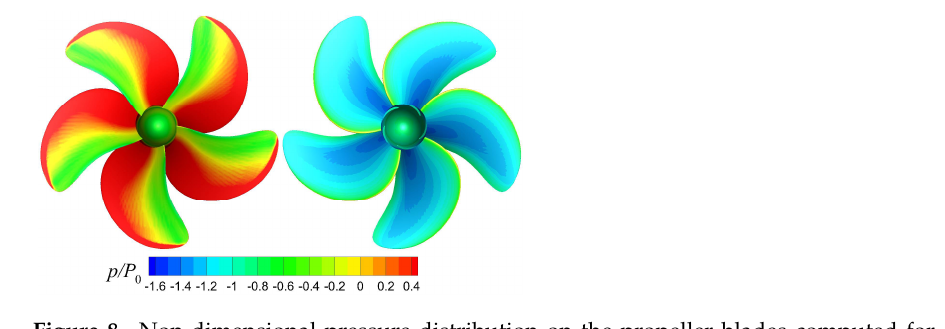
Figure 8. Non-dimensional pressure distribution on the propeller blades computed for J = 0.9: left—pressure side; right—suction side.